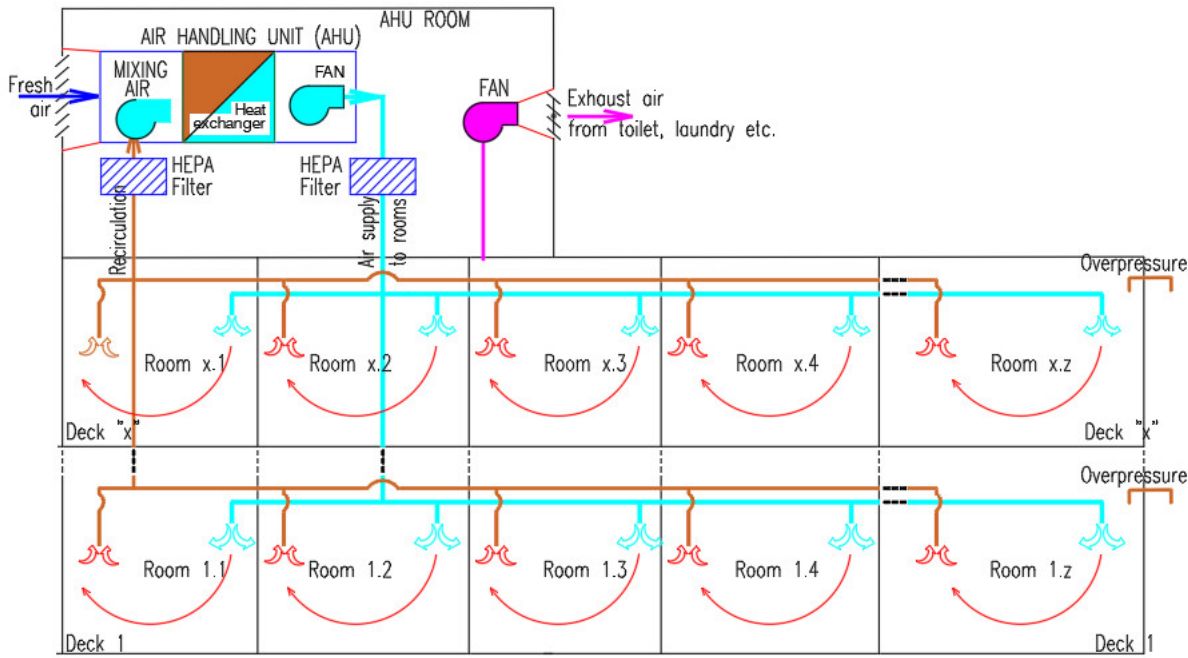
Figure 14. Example of typical arrangement. Common ventilation and air conditioning system for large ships, with recirculation and air mixing, provided with HEPA filters.